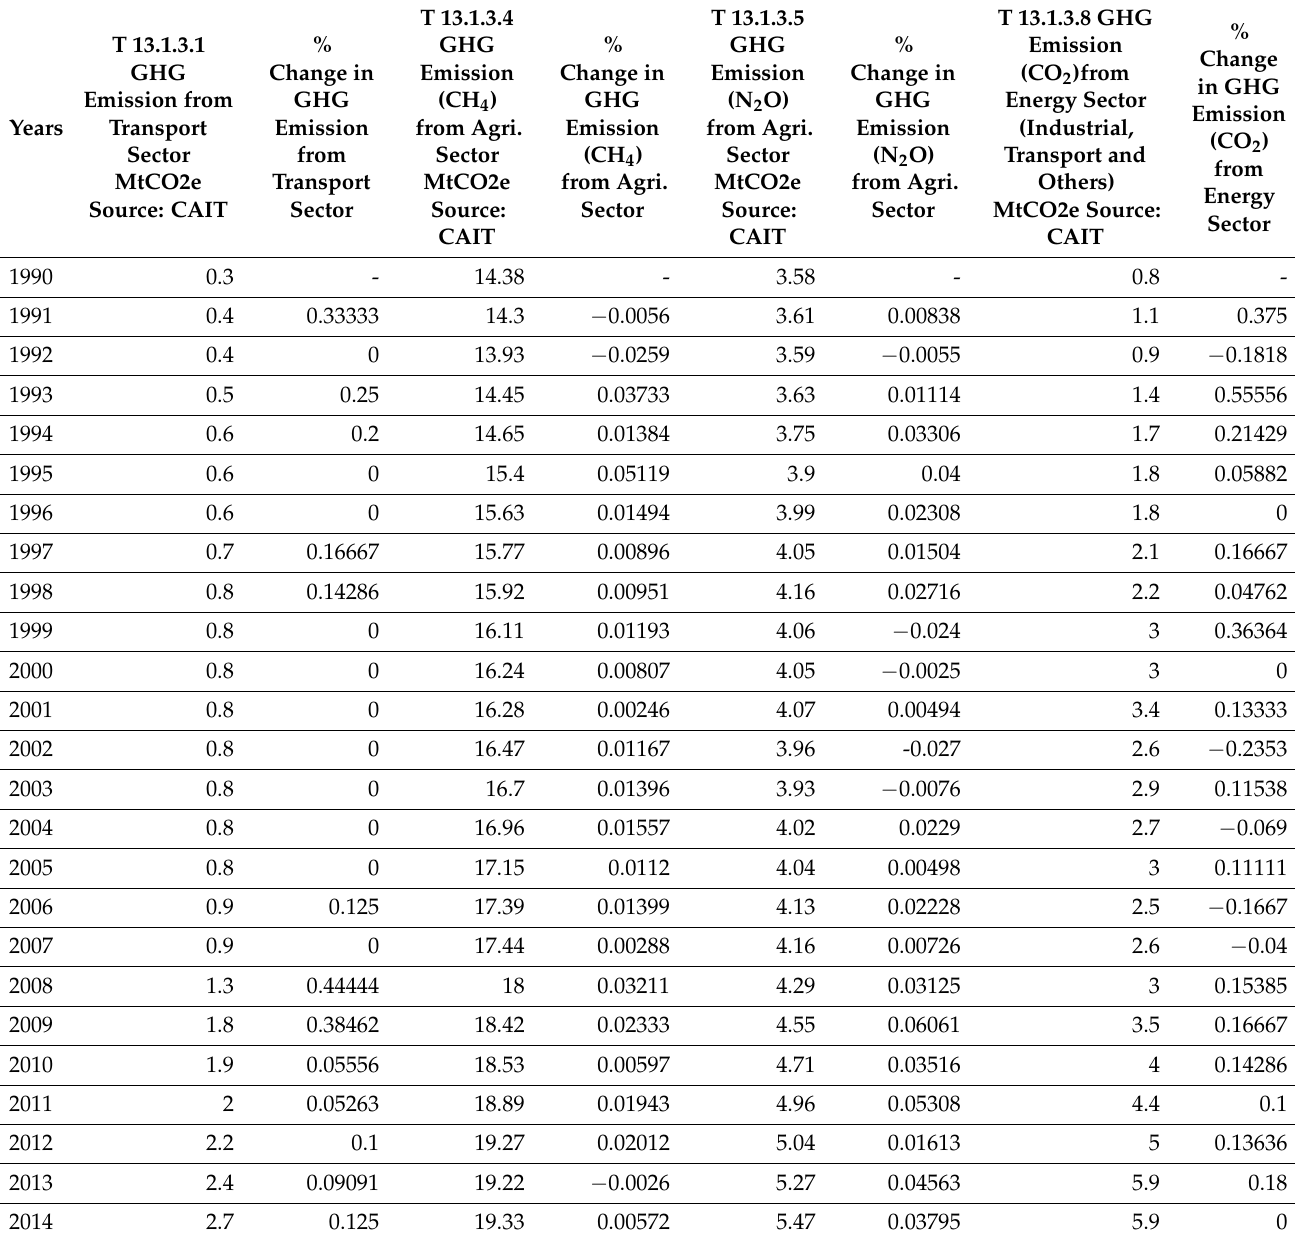
Table A1. Historical dataset for SDG13 and percent change